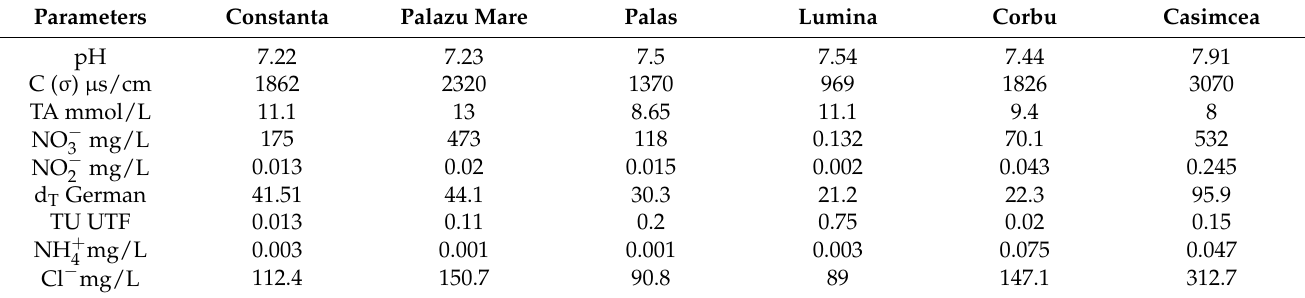
Table 2. Values of quality parameters for the studied samples.